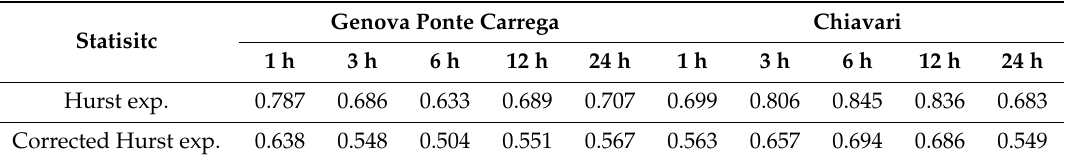
Table 8. The Hurst exponent, both classical formulation and the corrected one, for hourly rainfall series at Genova Ponte Carrega (1939–2019) and Chiavari (1932–2019) rain gauges. Genova Ponte Carrega Chiavari Statisitc 1 h 3 h 6 h 12 h 24 h 1 h 3 h 6 h 12 h 24 h Hurst exp. 0.787 0.686 0.633 0.689 0.707 0.699 0.806 0.845 0.836 0.683 Corrected Hurst exp. 0.638 0.548